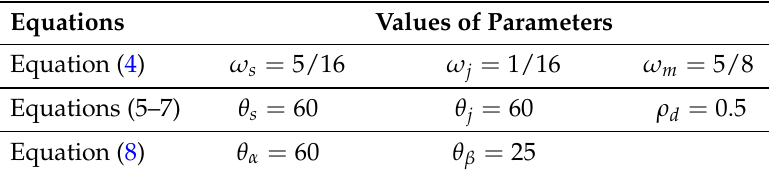
Table 1. The parameter settings for our experiments.